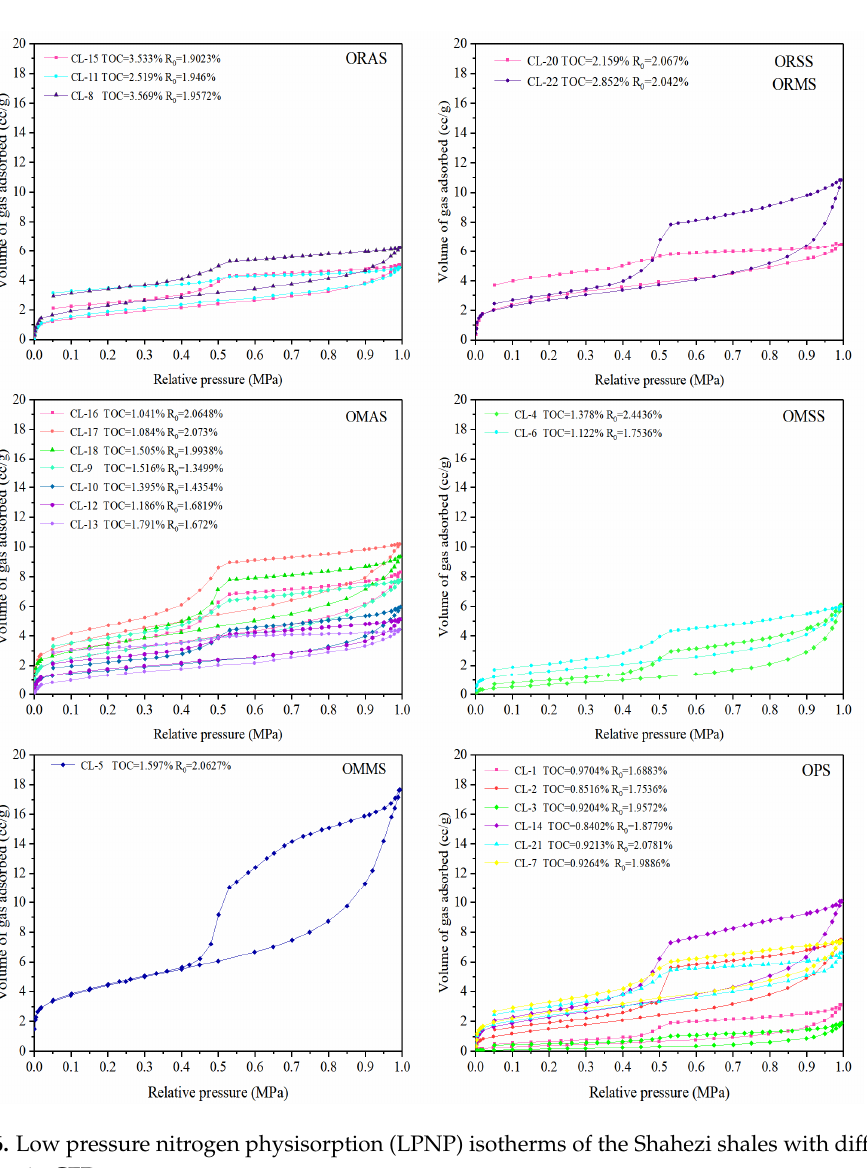
Table 2. Image processing results of representative elementary area (REA) for the Shahezi shale in CFD. Pore Type